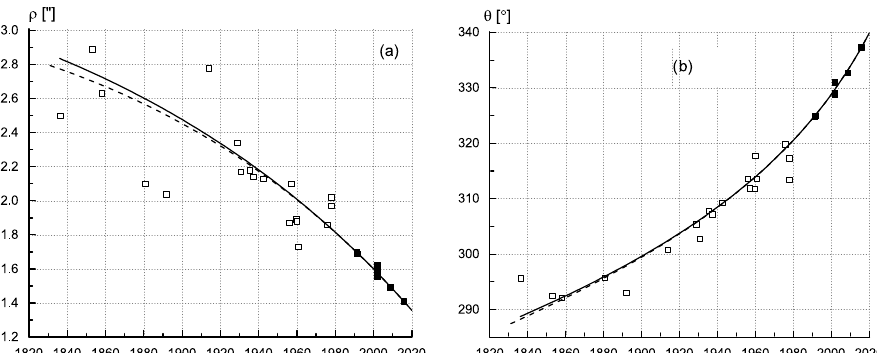
Fig. 2. HIP 50. Comparing orbits with observations: (cid:26) ( t ) (a), (cid:18) ( t ) (b). The coor- dinates of the main arc for AMP determinations are plotted as (cid:12)lled squares and other WDS observations, as open squares. The curves are ephemerides of the orbits: the orbit (cid:12)ts (cid:12) = +5 ◦ (solid curves); the orbit (cid:12)ts (cid:12) = (cid:0) 5 ◦ (dashed curves).